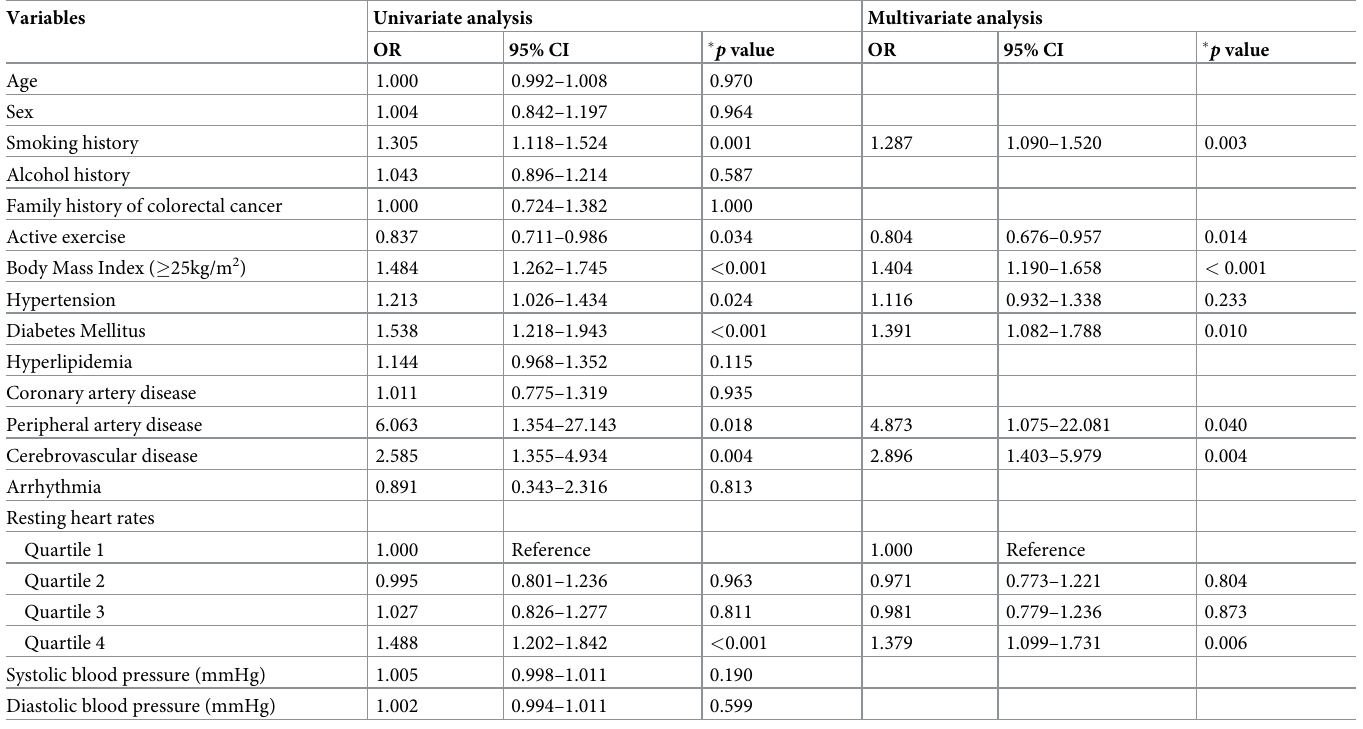
Table 4. Logistic regression analysis for advanced adenoma